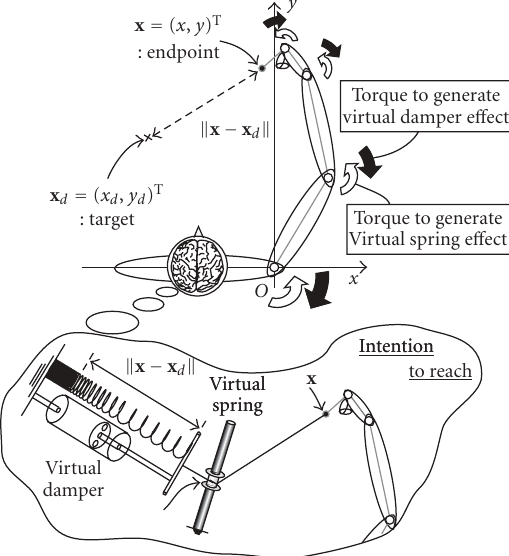
Figure 3: Virtual spring-damper hypothesis.